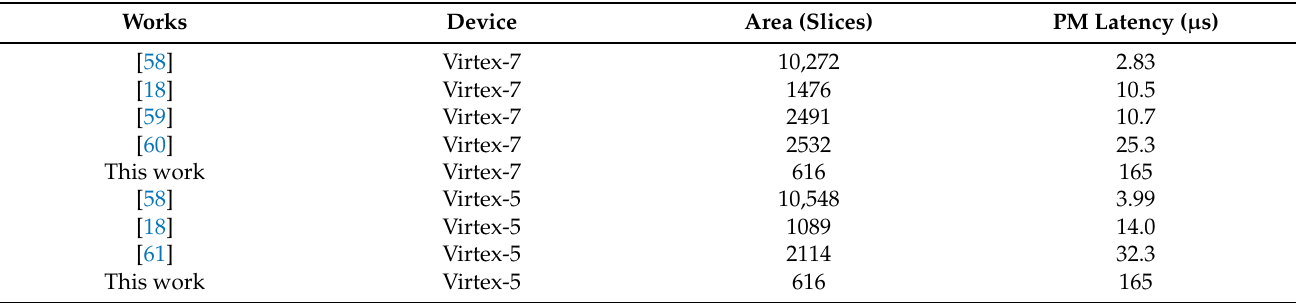
Table 6. ECC implementation results comparison.